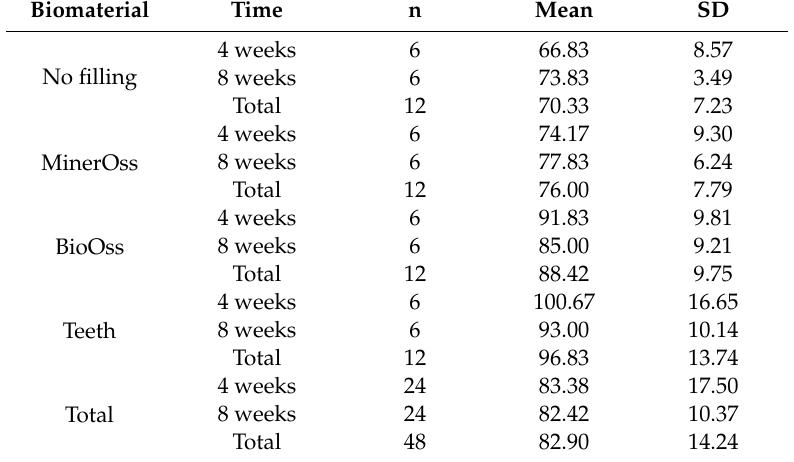
Table 5. The descriptive statistical values of di ff erences in radiological density percentages: Case count (n); Mean (%) and standard deviation (SD) according to material and stage.